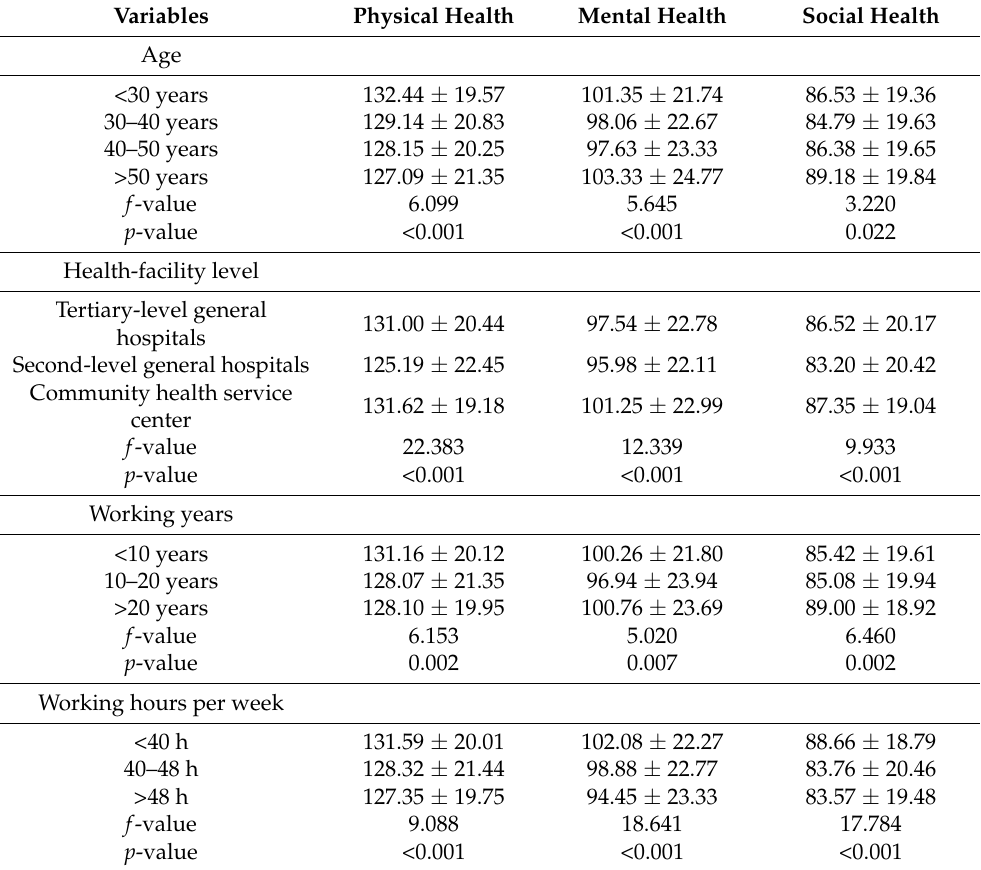
Table 3. Comparison of SRHMS score in different demographic and occupational